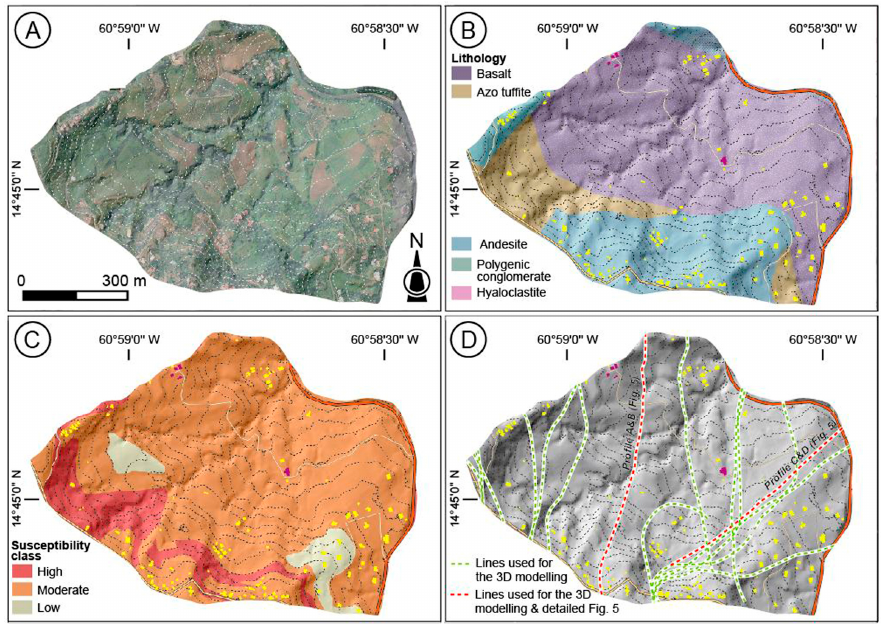
Figure 2. ( A ) Aerial photograph of the site (BD Ortho ® , IGN 2010) and geomorphological interpretations; ( B ) geological map made at 1:50,000 scale of work [45]; ( C ) official landslide susceptibility/hazard map (PPR); ( D ) locations of helicopter flight lines used for this research. (Coordinates are expressed in Lat/Long; projection WGS84 UTM 20N—EPSG 32620.)